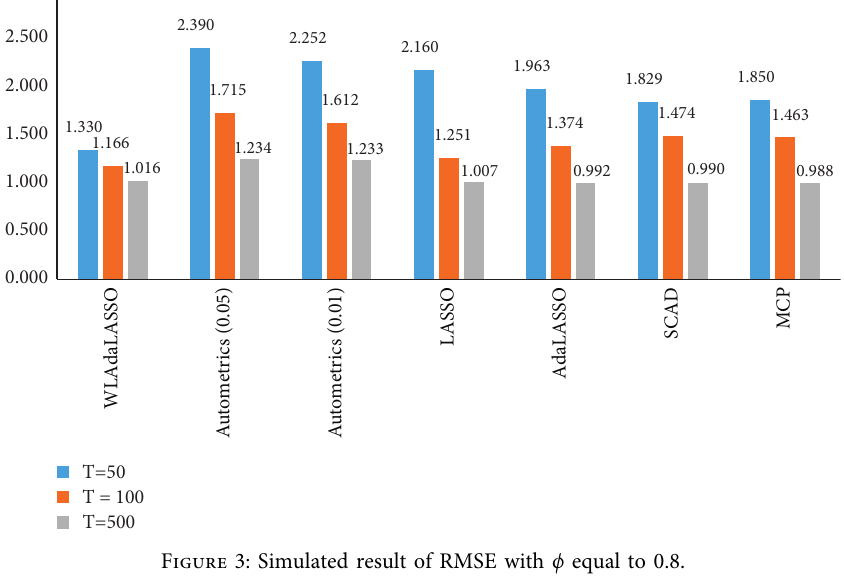
Figure 3: Simulated result of RMSE with ϕ equal to 0.8.